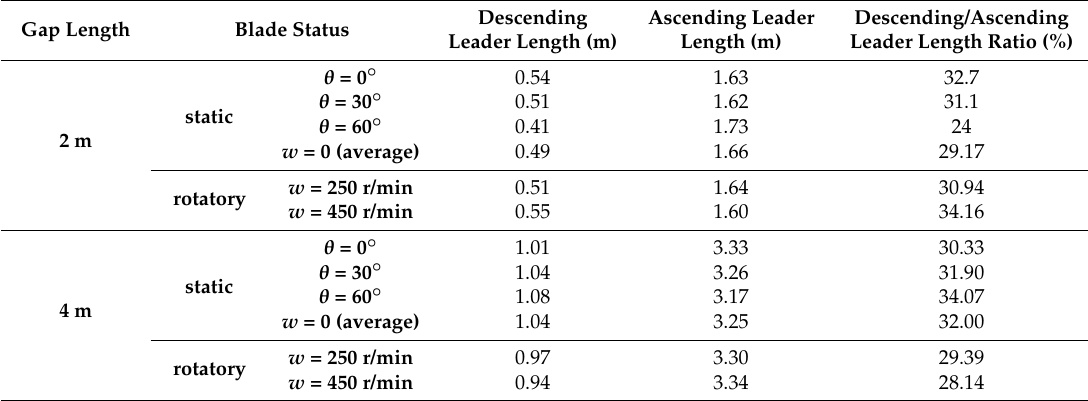
Table 4. The length of ascending and descending leaders under different blade statuses.